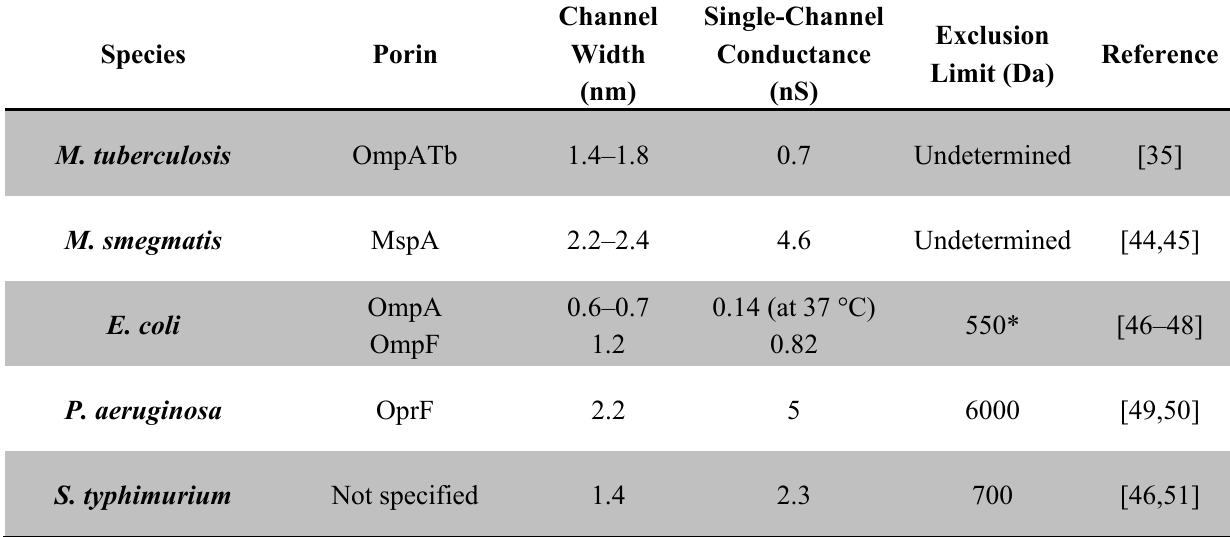
Table 2. Biophysical characteristics of OmpATb from M. tuberculosis and porins from other selected bacterial species. Exclusion limits were determined based on the uptake of saccharides of varied